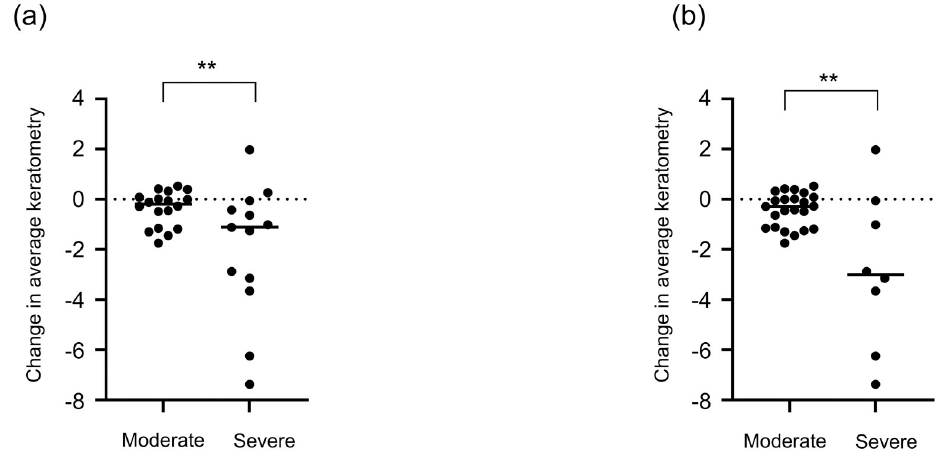
Fig 2. Changes in average keratometric values in patients with keratoconus using a RGP lens. (A) Comparison of keratometric changes during RGP lens use in eyes with severe and moderate KC based on the Amsler–Krumeich classification. The average keratometric value appears to have decreased in the severe KC group compared with that in the moderate KC group (p < 0.05, unpaired t-test). (B) Comparison of keratometric changes during RGP lens use in eyes with severe and moderate KC based on the Collaborative Longitudinal Evaluation of Keratoconus study group’s criteria. The average keratometric value appears to have significantly decreased in the severe KC group compared with that in the moderate KC group (p < 0.05, unpaired t-test). RGP, rigid gas-permeable contact, KC,